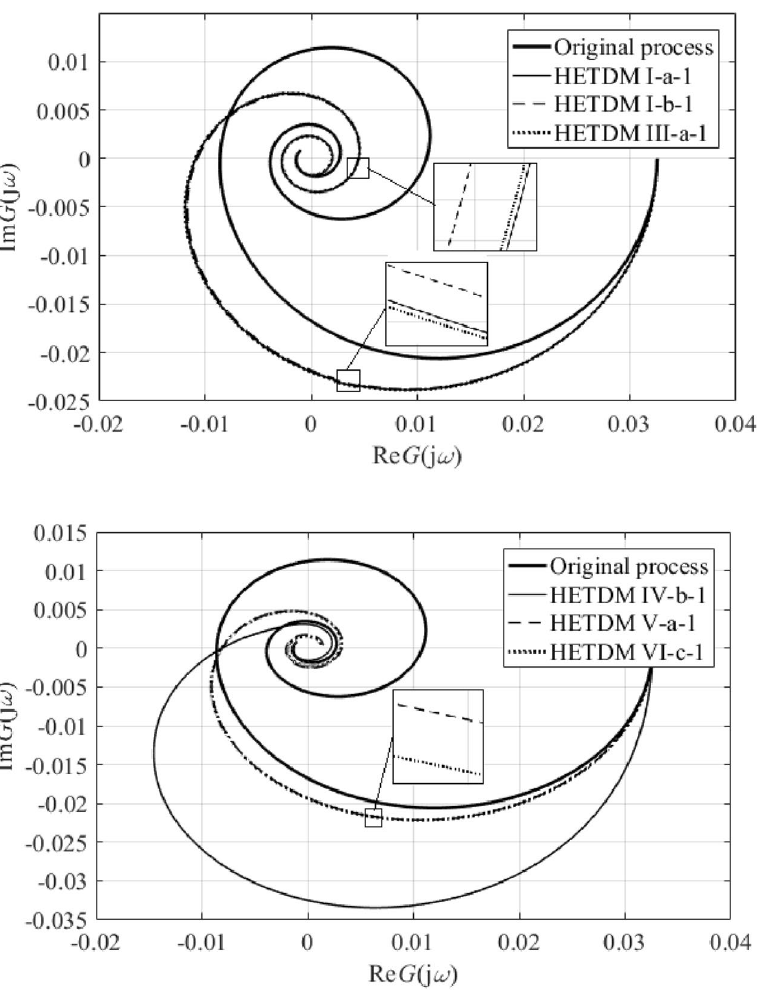
Figure 13. Comparison of selected HETDM Nyquist plots (vs. the original process response)—LM method used for transfer function numerator parameters computation.